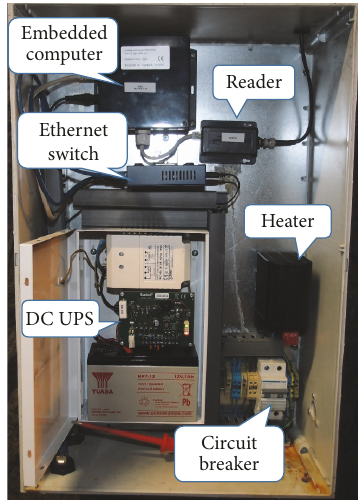
Figure 2: Reader with integrated